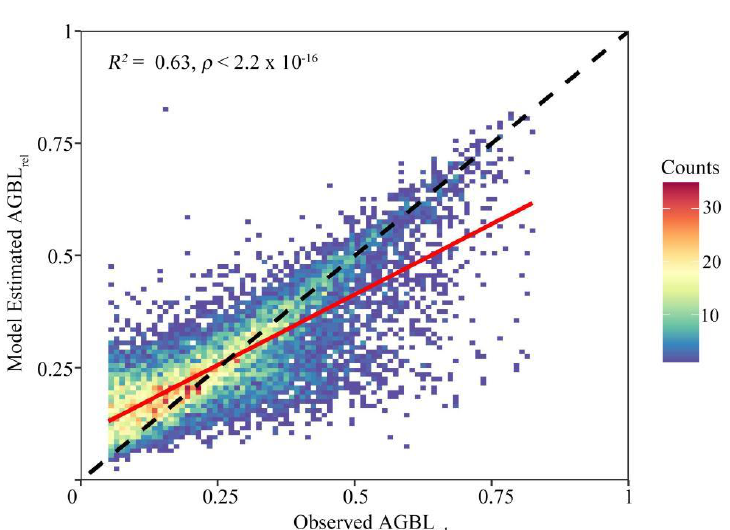
Figure 3. Error scatter plot of the optimal model (Model ID: StackedEnsemble_AllModels in Table 2) simulation AGBL rel and observed AGB rel in the test